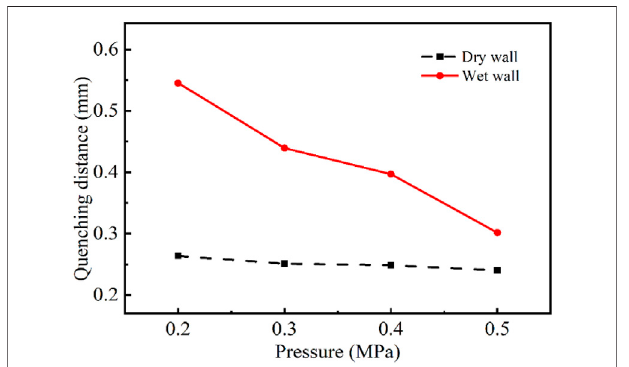
FIGURE 11 | Distribution of UHC, CO, C 2 H 2 and C 3 H 3 in the quenching aera under dry and wet wall